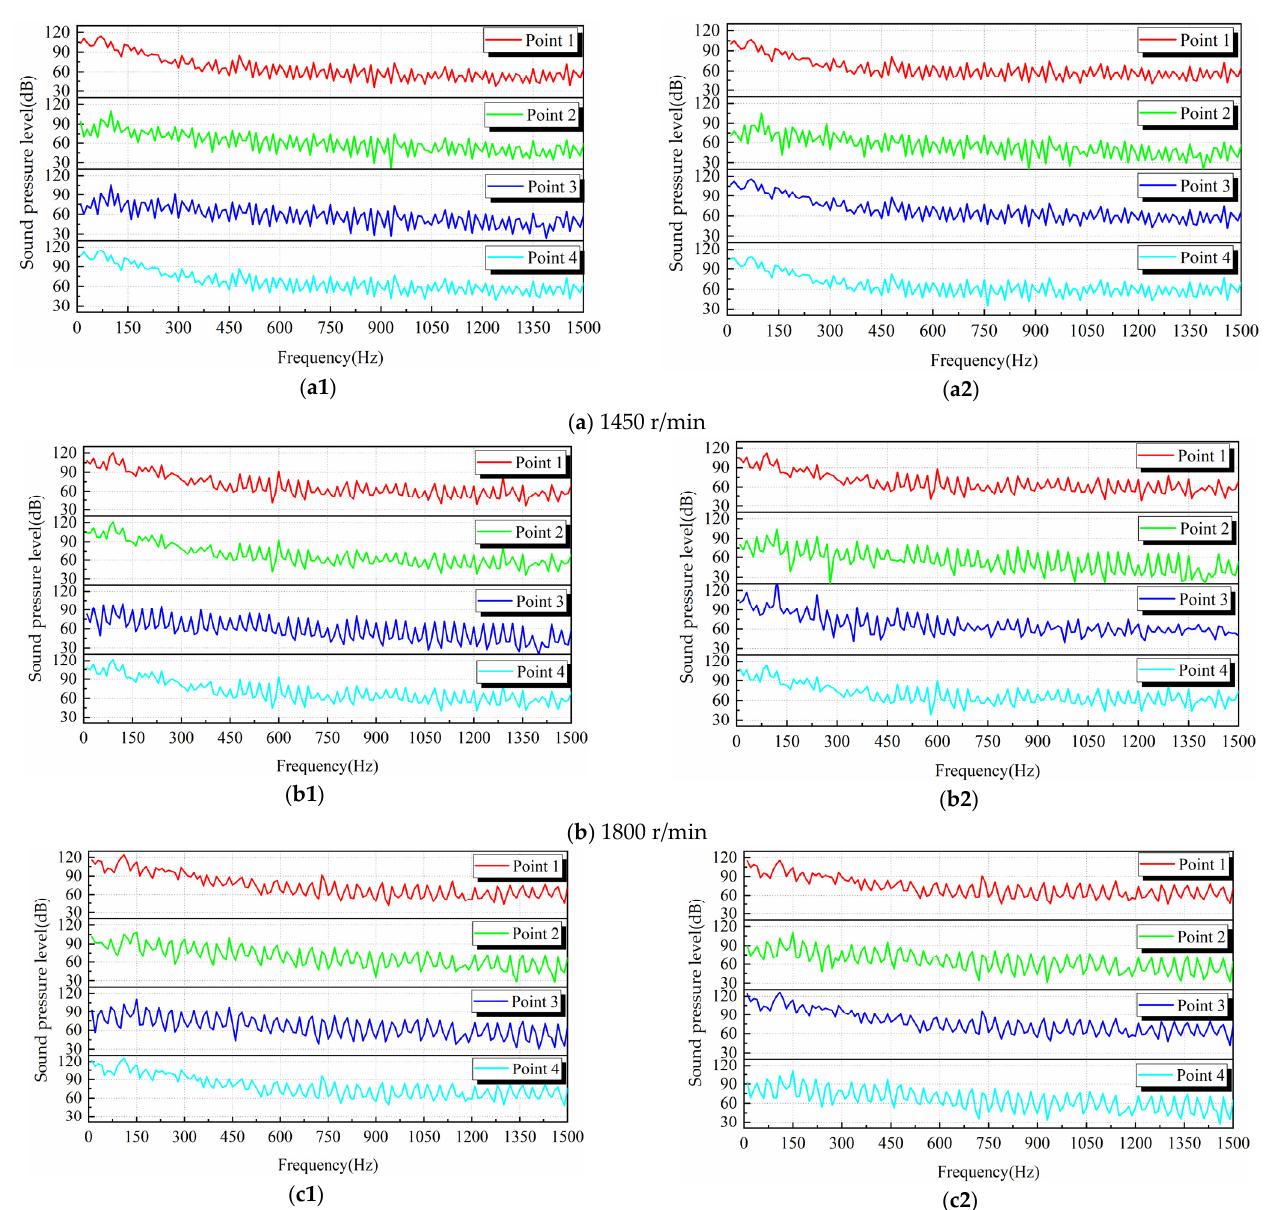
Figure 14. Frequency response curve of sound-pressure level in the inlet and outlet conduits at different rotation speeds. ( a ) 1450 r/min. ( b ) 1800 r/min. ( c ) 2200 r/min. ( a1 ) Sound pressure level of the inlet conduit. ( a2 ) Sound pressure level of outlet conduit. ( b1 ) Sound pressure level of the inlet conduit. ( b2 ) Sound pressure level of outlet conduit. ( c1 ) Sound pressure level of the inlet conduit. ( c2 ) Sound pressure level of outlet conduit.